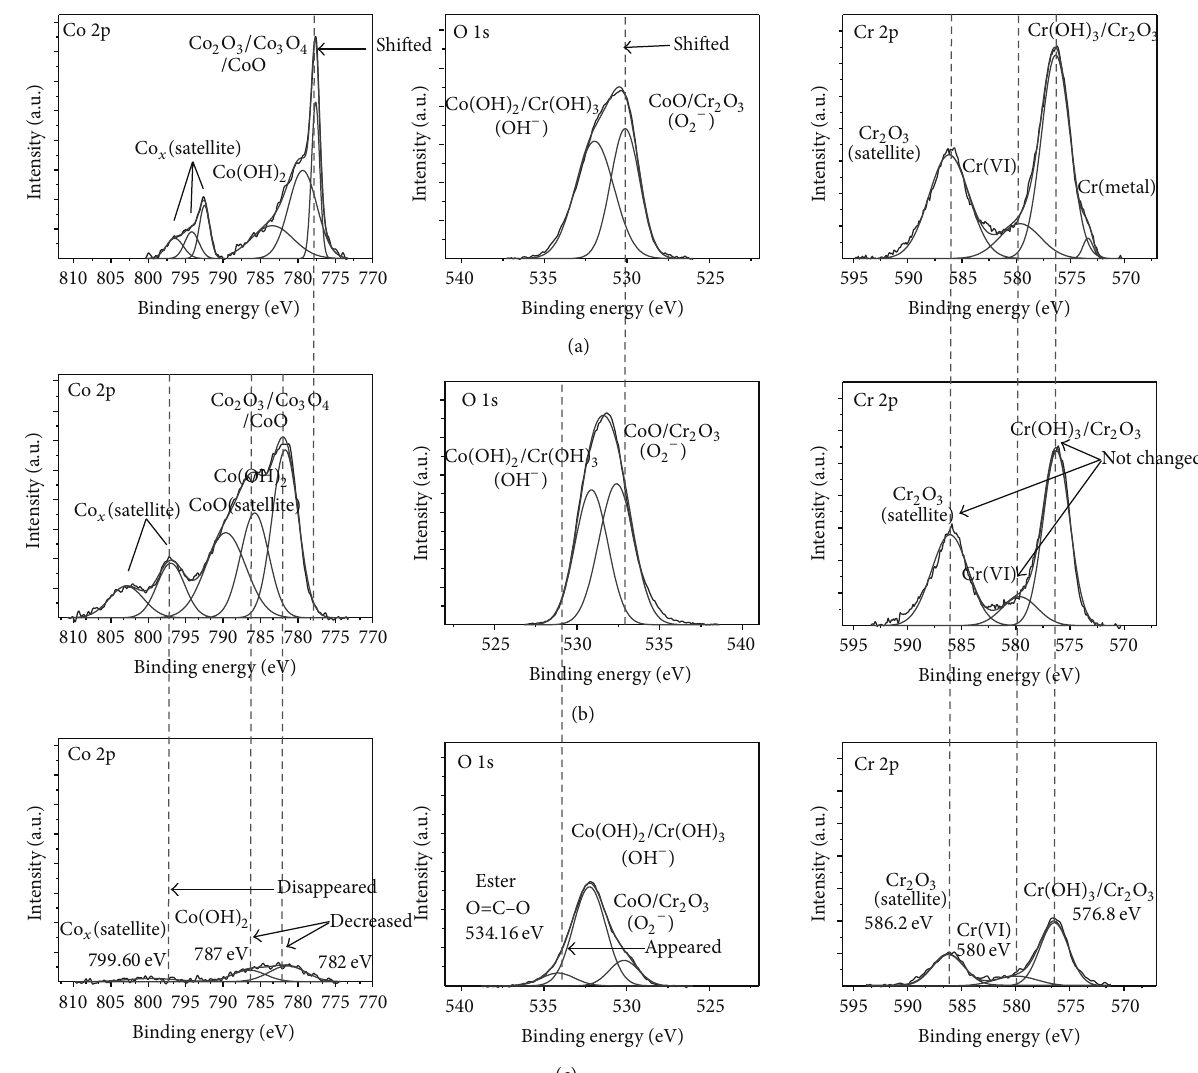
Figure 2: XPS analysis of (a) the pure Co-Cr alloy plate, (b) the oxidized Co-Cr alloy plate, and (c) the Hp bonded Co-Cr alloy plate.